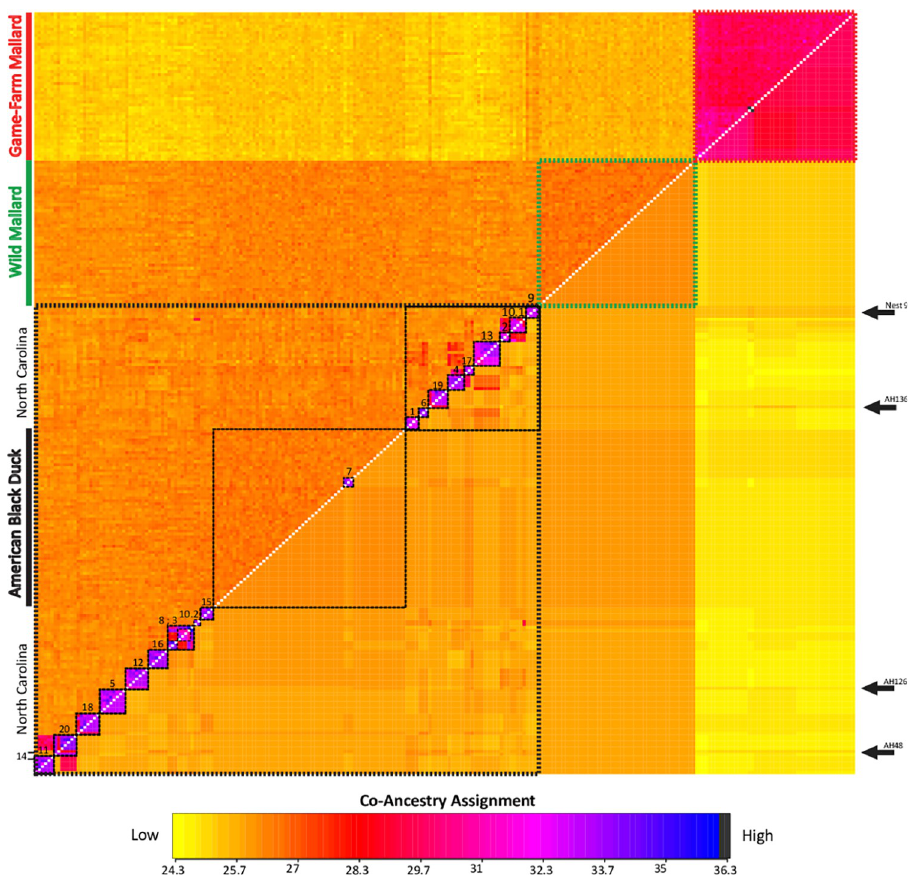
Fig 2. FineRADstructure individual (above diagonal) and average (below diagonal) co-ancestry coefficient matrix based on a 6,622 independent bi-allelic ddRAD-seq autosomal SNP dataset for sampled reference American black ducks, wild mallards, and game-farm mallards, and samples from North Carolina, USA, 2020–2021. Samples are color coded by reference species or population. The level of co-ancestry is color coded from low (yellow) to high (blue). The 20 genetic clusters found across the 99 North Carolina samples are numbered and correspond to their nest identity (S1 Table). Finally, arrows denote the group (i.e., nest 9) or individuals that showed higher-than average levels of co-ancestry with game-farm